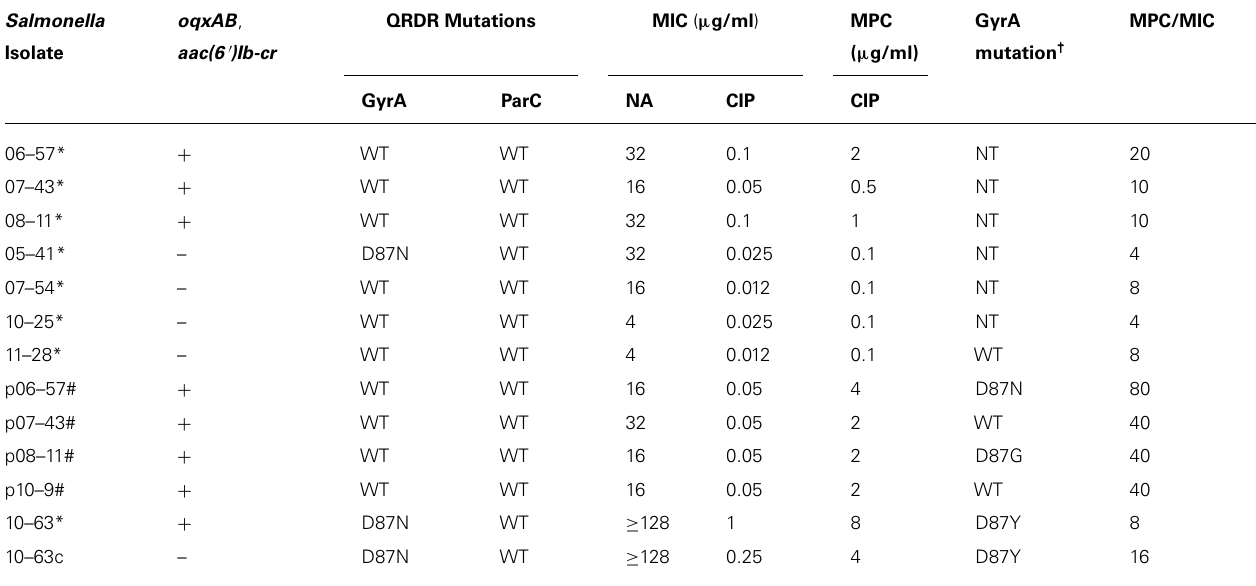
Table 3 | MICs of nalidixic acid (NA) and ciprofloxacin (CIP) and mutation prevention concentration (MPC) toward CIP of Salmonella isolates with various background of oqxAB and aac(6 (cid:2) )Ib-cr .